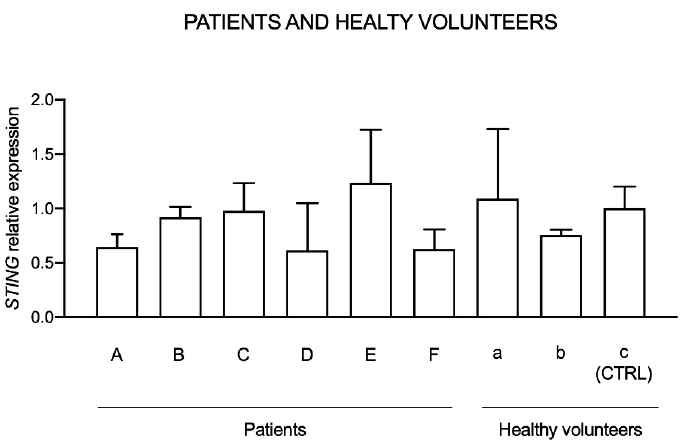
Figure 5. STING expression in patients (A–F) suffering from type I interferon dysregulations and healthy individuals (a–c). Data are reported evaluating 2 −ΔΔ Ct values, using healthy volunteer “c” as calibrator (CTRL) and HPRT1 and G6DP housekeeping genes as reference.